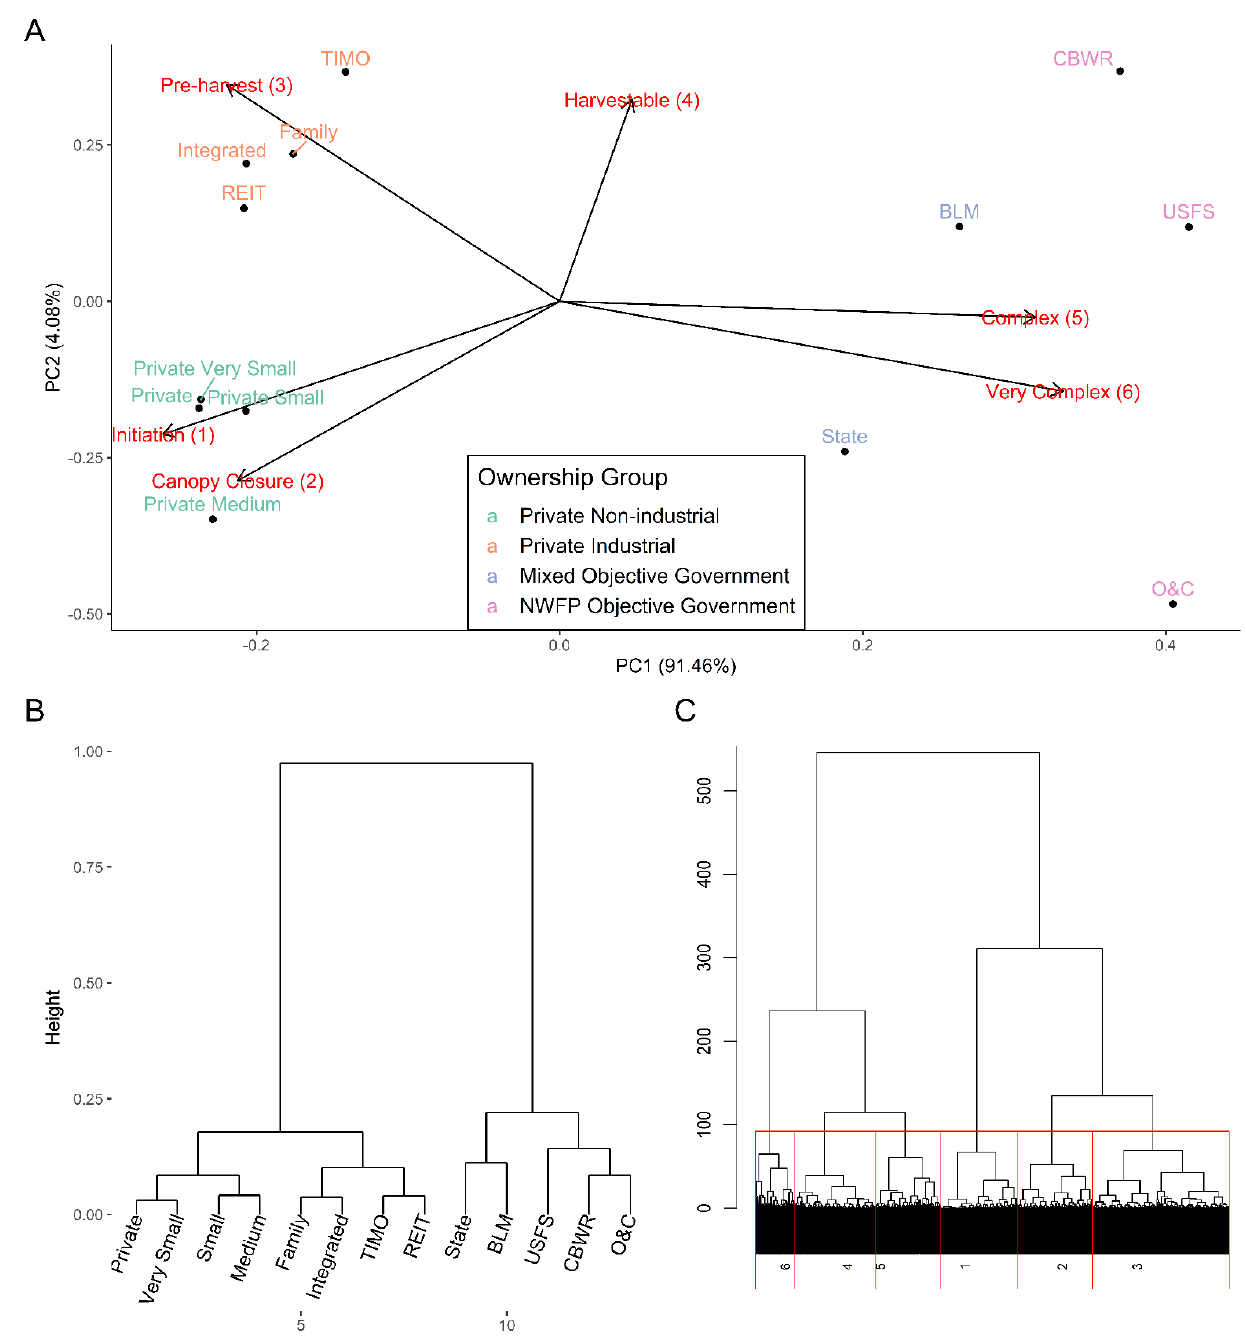
Figure 3. ( A ) Ordination of Principal Component Analysis of forest structure classes. Ownership types are overlaid on the ordination to show their relationships with each of the forest structure classes. Ownership types are colored based on their assigned hierarchical clustering group. ( B ) Dendrogram of ownership types from hierarchical clustering by percent area of structure class. ( C ) Dendrogram of structure classes (numbers 1–6 in figure) from hierarchical clustering of lidar metrics (P95, P25, canopy cover, rumple).